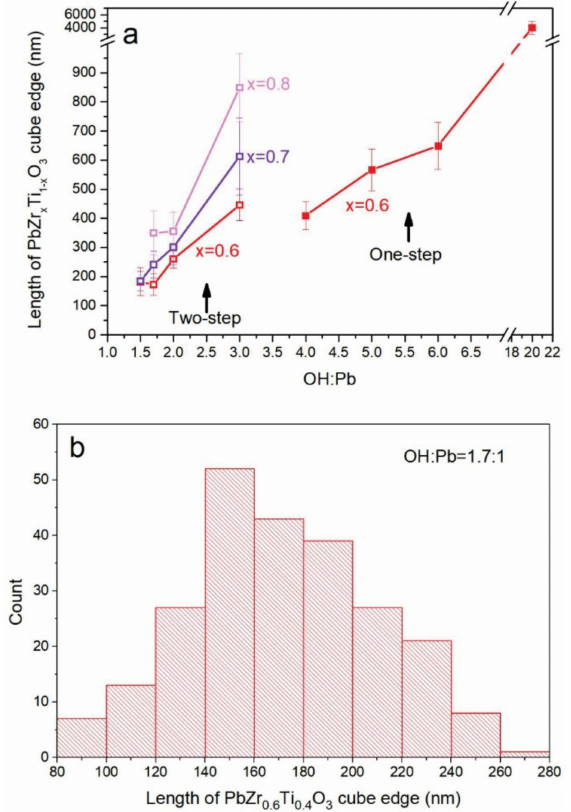
Figure 4. ( a ) Size of the PbZr x Ti 1-x O 3 (PZT) cubes (length of cube edge) versus KOH:Pb ratio for the PZT synthesized through one-step (PZT06, x = 0.6) and two-step precipitation approaches (PZT06 (x = 0.6), PZT07 (x = 0.7), PZT08 (x = 0.8)). ( b ) Histogram of the size distribution (length of cube